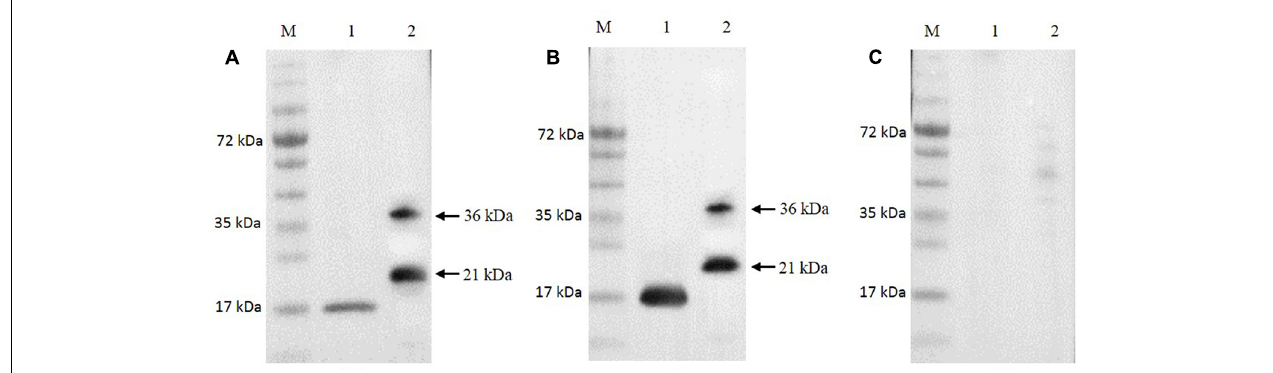
FIGURE 2 | Expression of native MEDLE-2 protein in Cryptosporidium parvum sporozoites. Polyclonal IgG antibodies (A) , immune serum (B) and pre-immune serum (C) were used in Western blot analysis of total proteins extracted from C. parvum oocysts and recombinant proteins. Lane M: protein size makers; Lane 1: native proteins from C. parvum ; Lane 2: recombinant MEDLE-2.